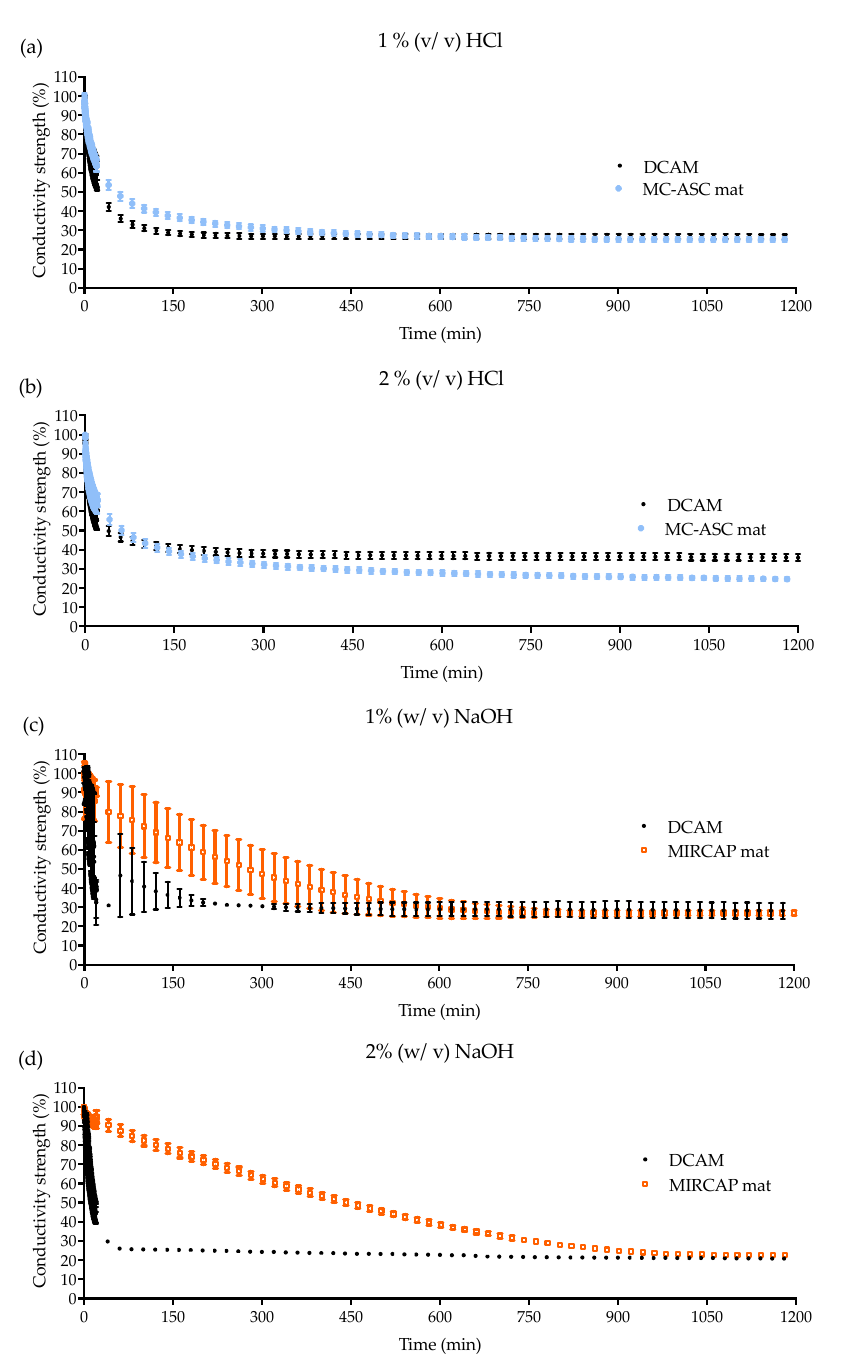
Figure 4. Conductivity profiles of solutions in contact with DCAM in: ( a ) HCl 1% ( v / v ), ( b ) HCl 2% ( v / v ), ( c ) NaOH 1% ( v / v ), and ( d ) NaOH 2% ( v / v ) (the results represent the average of